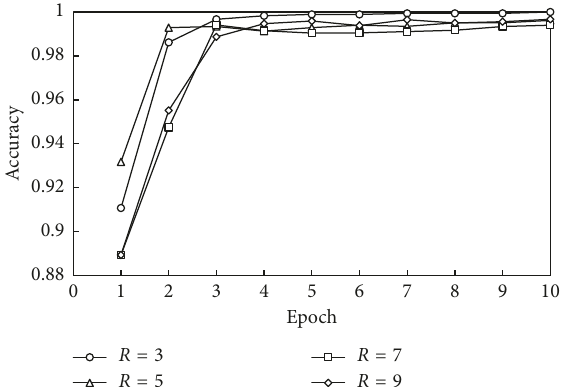
Figure 20: Training results of different R